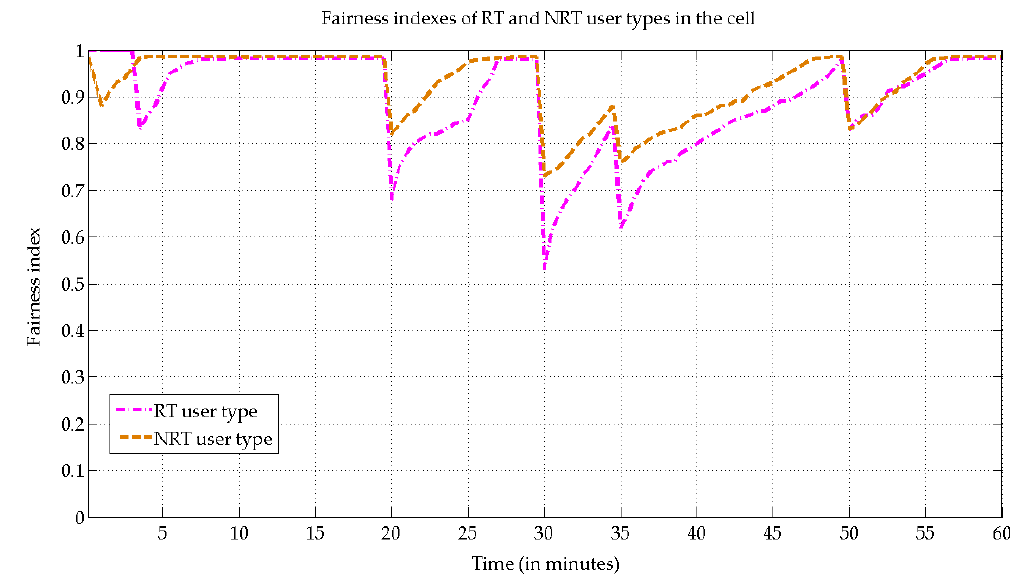
Figure 8. Fairness indexes over time for the RT user type and NRT user type under the proposed scheme.